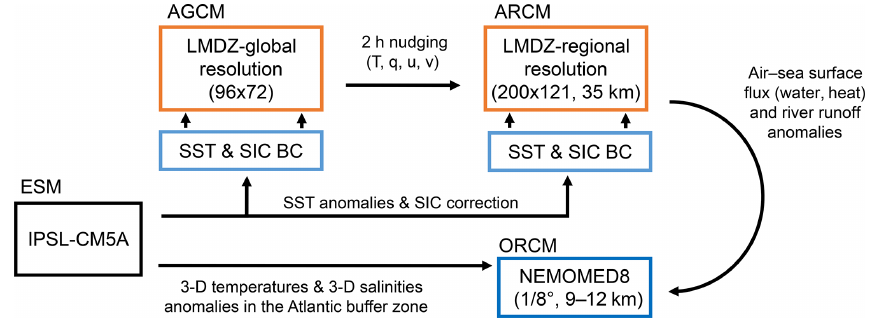
Figure 1. Flowchart of the modelling chain including the four main components generally represented by ESM, AGCM, ARCM and ORCM, respectively, and actually implemented in our platform by IPSL-CM5A, LMDZ-global, LMDZ-regional and NEMOMED8. BC: boundary condition, u : zonal wind, v : meridional wind, q : specific humidity, T : temperature, S : salinity, SST: sea surface temperature, SIC: sea-ice